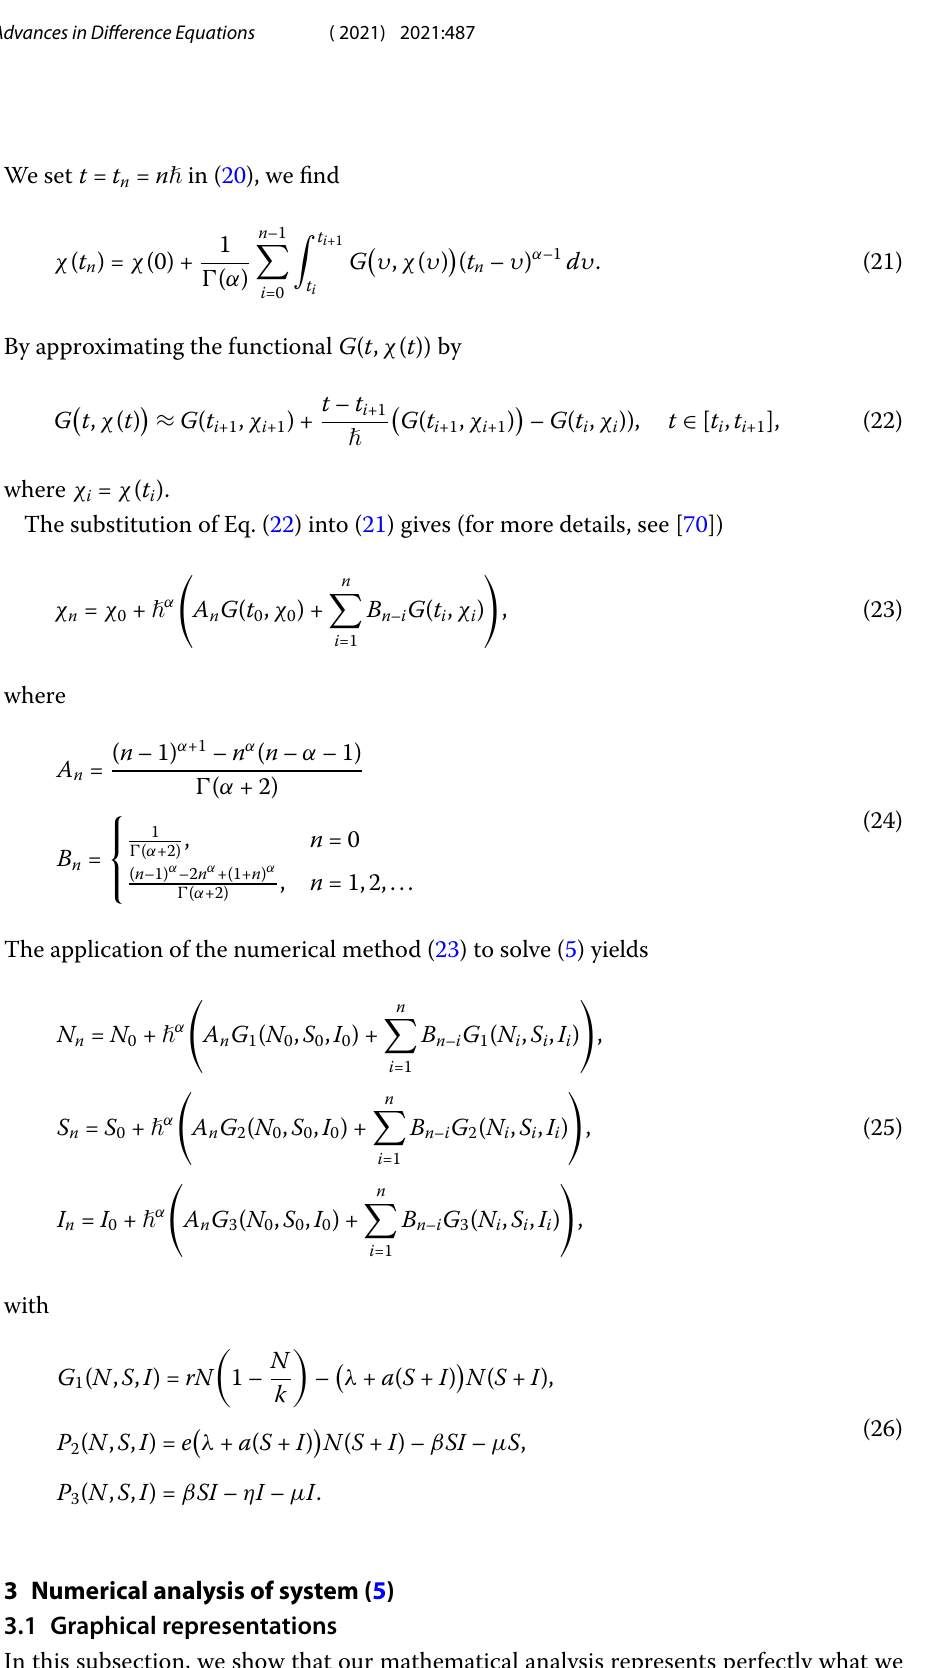
Fig. 3: Here we consider α = 0.9 , r = 1.2 , k = 2.5 , η = 0.5 , λ = 0.5 , μ = 0.5 , a = 3.5 , β = 0.5 , e = 0.5 . Hence we get the stability of the DFE (cid:9) 3 = (0.45,0.46,0)